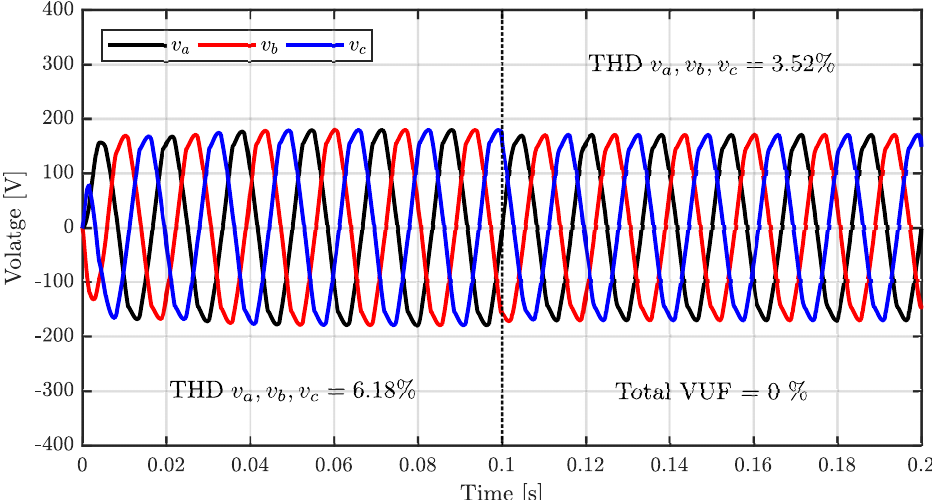
Figure 18. MG response under nonlinear compensation operating in grid-tied mode and with balanced linear and nonlinear loads.